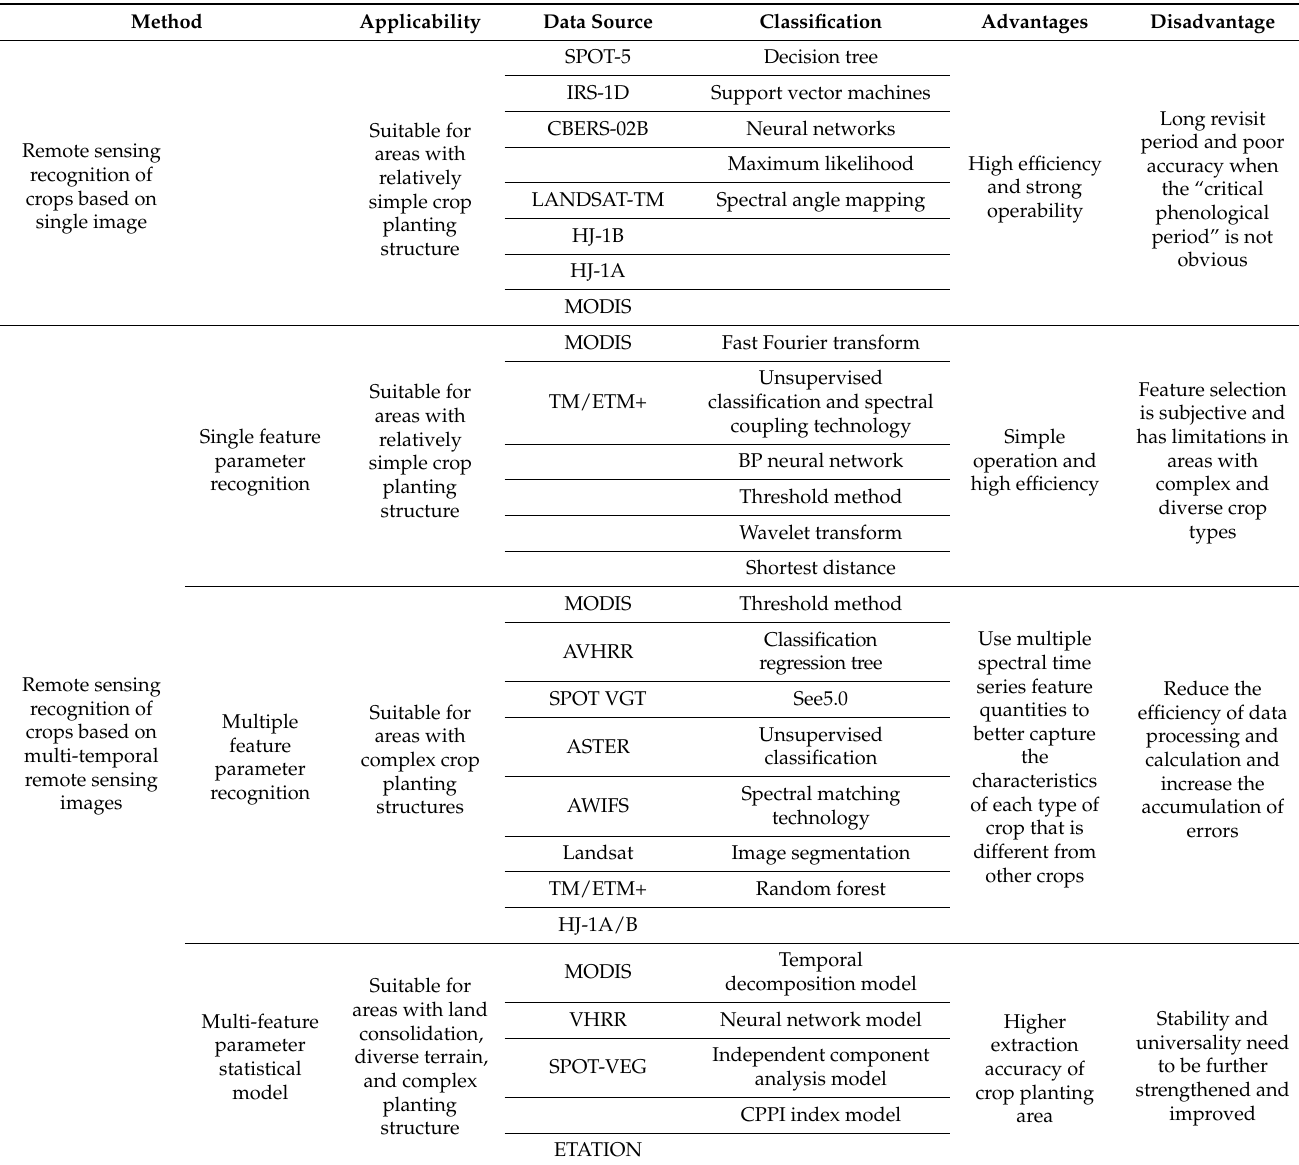
Table 2. Comparison of remote sensing identification methods for farmland vegetation based on spectral